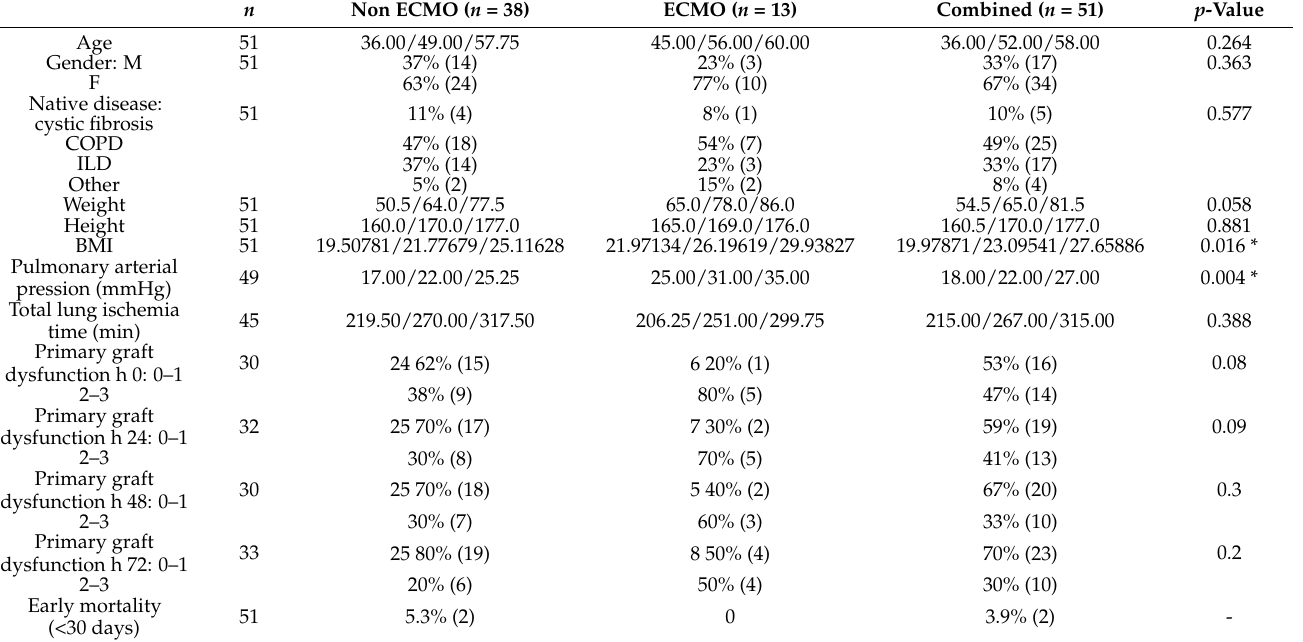
Table 1. Study population: descriptive statistics. Continuous data are reported as medians (I, III quartiles); categorical data are reported as percentages and absolute frequencies. Wilcoxon-type tests were performed for continuous variables, and Pearson chi-square tests were performed for categorical variables.